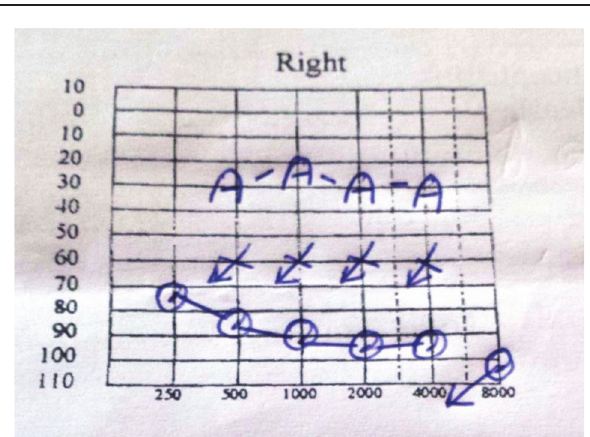
Showing audiogram of one patient with severe sensorineural hearing loss and aided response using pair of linear frequency transposition hearing